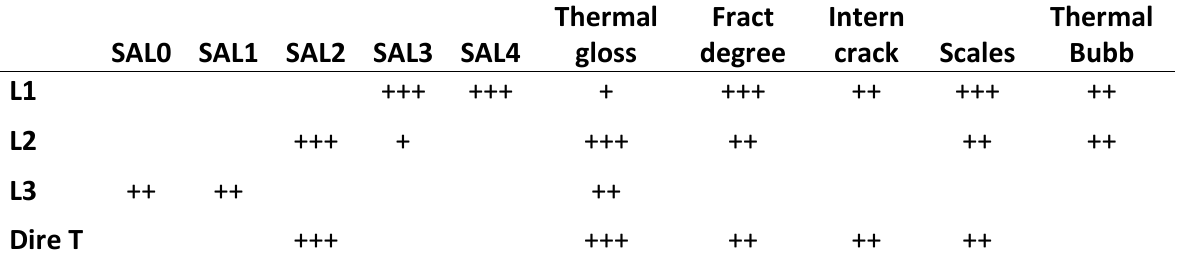
Table 1. Observed comparative patterns of development of heat alterations (Bergerac flint blanks). Abbreviations: + - low presence or low development of feature; ++ - feature commonly present; +++ - feature present in all cases and highly developed; blank cells indicate absence of feature; Dire T - blanks thrown directly.